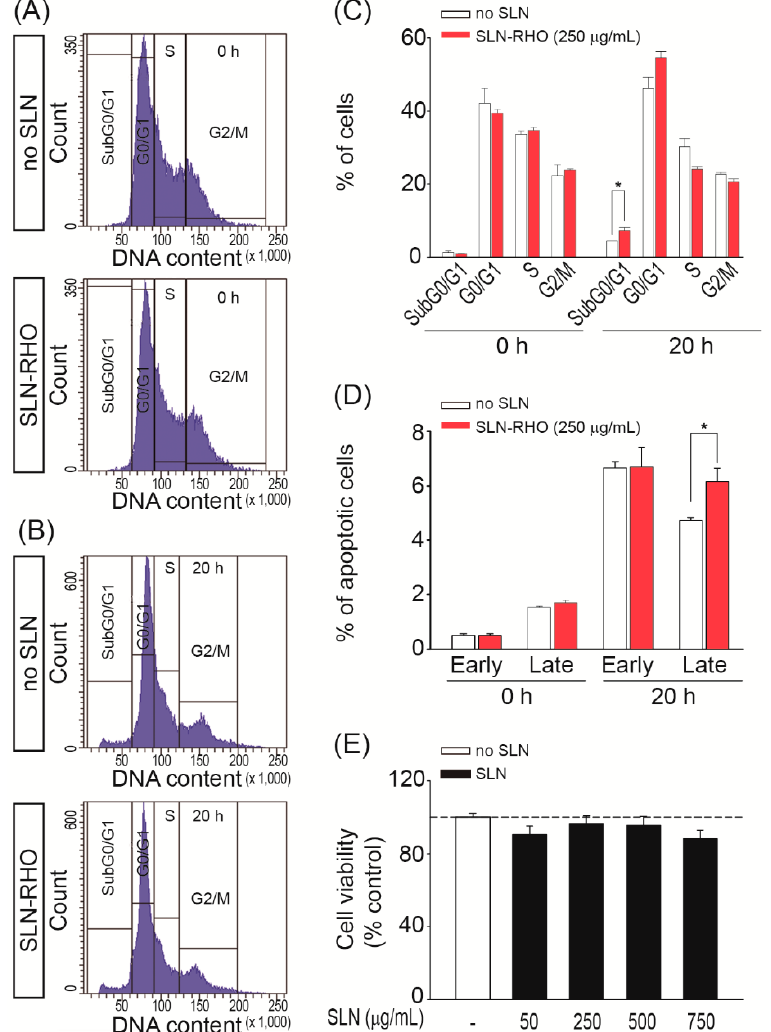
Figure 3. The cytotoxicity of SLN–RHO and SLN in HEI-OC1 cells. ( A ) Flow cytometry analysis of cell cycle phase distribution in HEI-OC1 cells. Representative profiles of DAPI staining from control (no SLN) and SLN–RHO (250 µ g / mL) treated cell cultures, at 0 h ( A ) and 20 h ( B ). ( C ) Histogram showing the cell distribution in the sub-G0 / G1, G0 / G1, S and G2 / M phases in control and SLN–RHO (250 µ g / mL) treated-cells. ( D ) HEI-OC1 cells were incubated or not with SLN–RHO for 20 h, stained with FITC-conjugated Annexin V and PI, and the pencentages of cell populations in early and late apoptosis were quantified. Data are shown as the mean ± SEM from three independent experiments. The significance of the di ff erences was evaluated using Student´ t tests; * p < 0.05 versus control condition (without SLNs). ( E ) HEI-OC1 cells were seeded into 96-well microplates 1500 cells / well and treated with the doses indicated of SLN for 24 h. Cell viability was determined with the Cell Proliferation Kit II (XTT) assay. Results are the mean ± SEM of two-three independent experiments performed in quadruplicate. The significance of the di ff erences was evaluated using one-way ANOVA testing; * p <